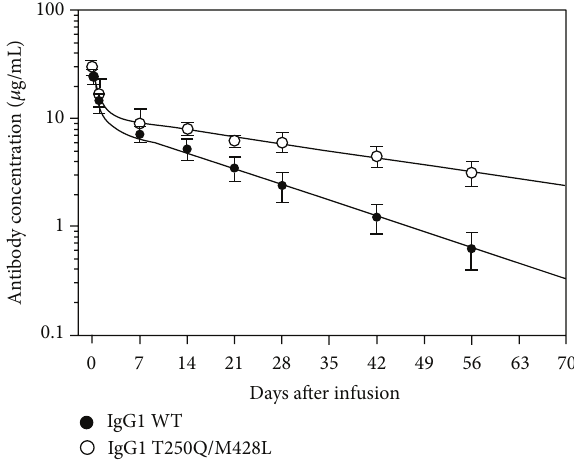
Figure 5: PK profile of OST577-IgG1 WT and mutant Abs following intravenous injection to rhesus monkeys. The concentration of OST577-IgG1 Abs in rhesus serum was measured in a validated ELISA using the mouse anti-OST577 anti-Id mAb for capture and the HRP-conjugated goat anti-human 𝜆 L chain Ab for detection (adapted and modified from Figure 2,